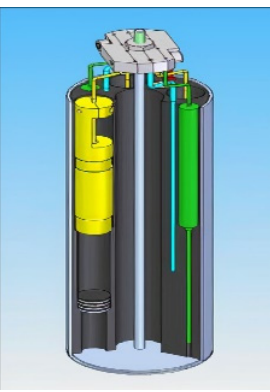
Figure 4. 3D renderings of the ultra-capsule as constructed for the irradiation. The bismuth titanate (BiTi) sensor is shown in yellow [14].